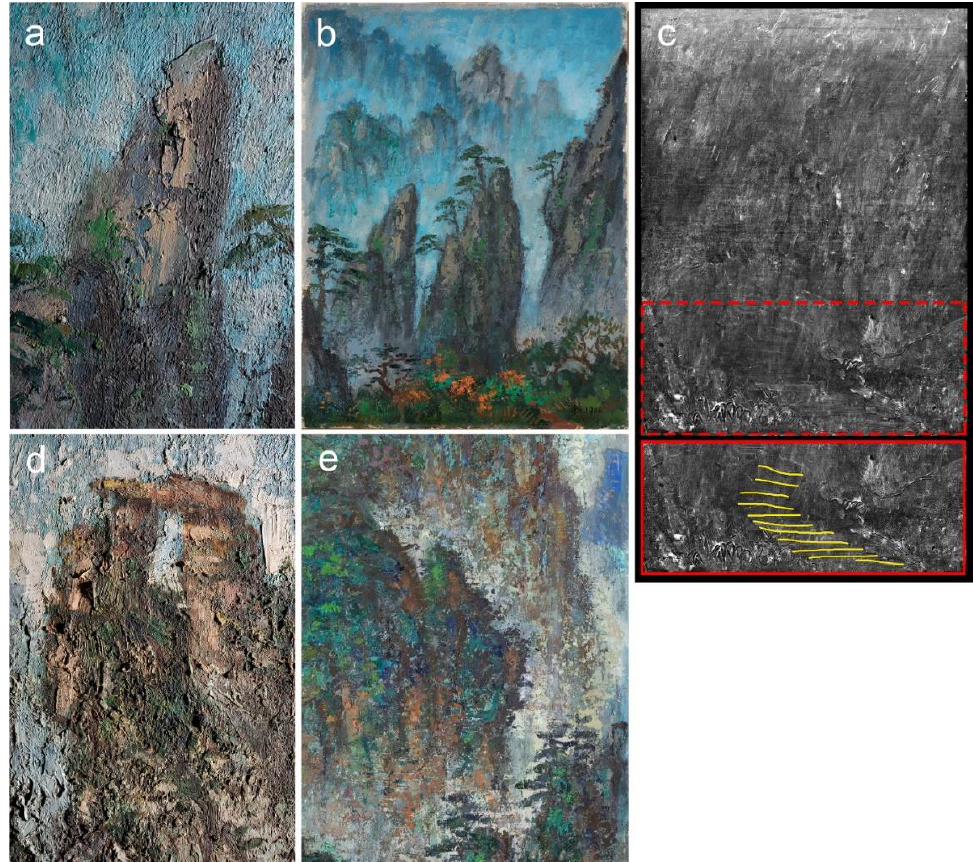
Figure 21. ( a ) Detail of Mount Huangshan , 1996, showing a brush and palette knife paint application. ( b ) Image of the same painting photographed in VIS and ( c ) corresponding XRR image and detail with superimposed tracing of the winding path. ( d ) Detail of Mountain , 1981, showing high impastos. ( e ) Detail of Mount Huangshan , 1986, showing the juxtaposing touches of paint for the execution of the misty and translucent air.